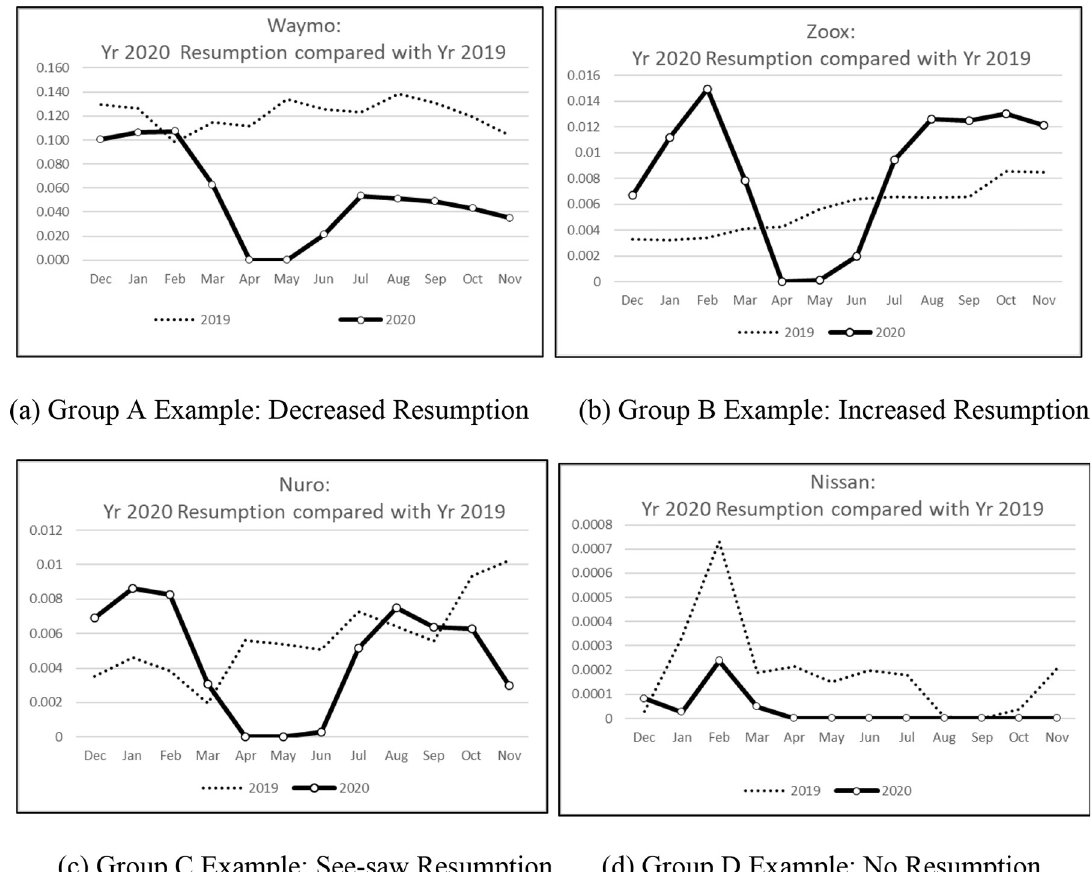
Fig 2. Test Mileage Resumptions of four example companies each respectively drawn from Groups A, B, C and D (mVMT). (a) Group A Example: Decreased Resumption (b) Group B Example: Increased Resumption (c) Group C Example: See-saw Resumption (d) Group D Example: No